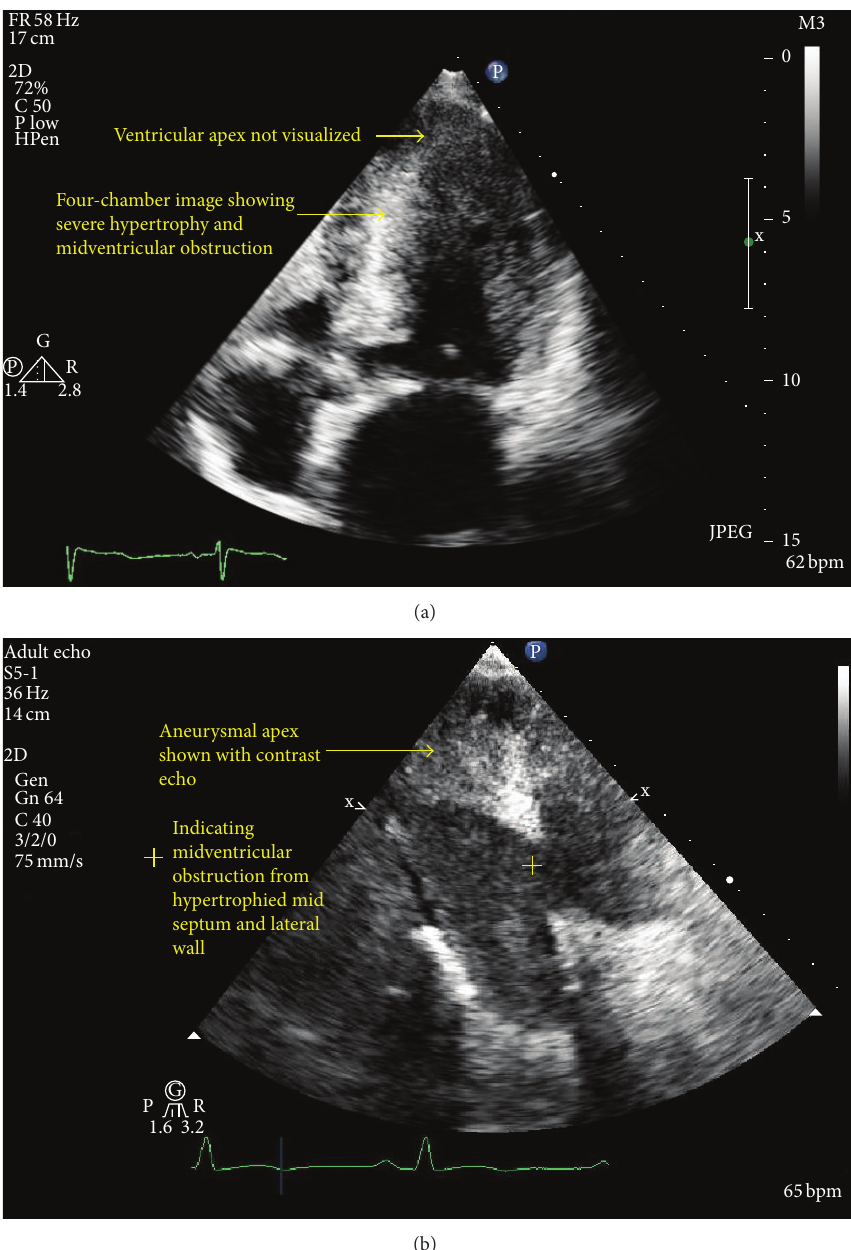
Figure 3: (a) Noncontrast transthoracic echocardiographic 4-chamber image demonstrating left ventricular hypertrophy and inability to visualize apical pouch. (b) Contrast transthoracic echocardiographic image demonstrating midventricular narrowing with aneurysmal